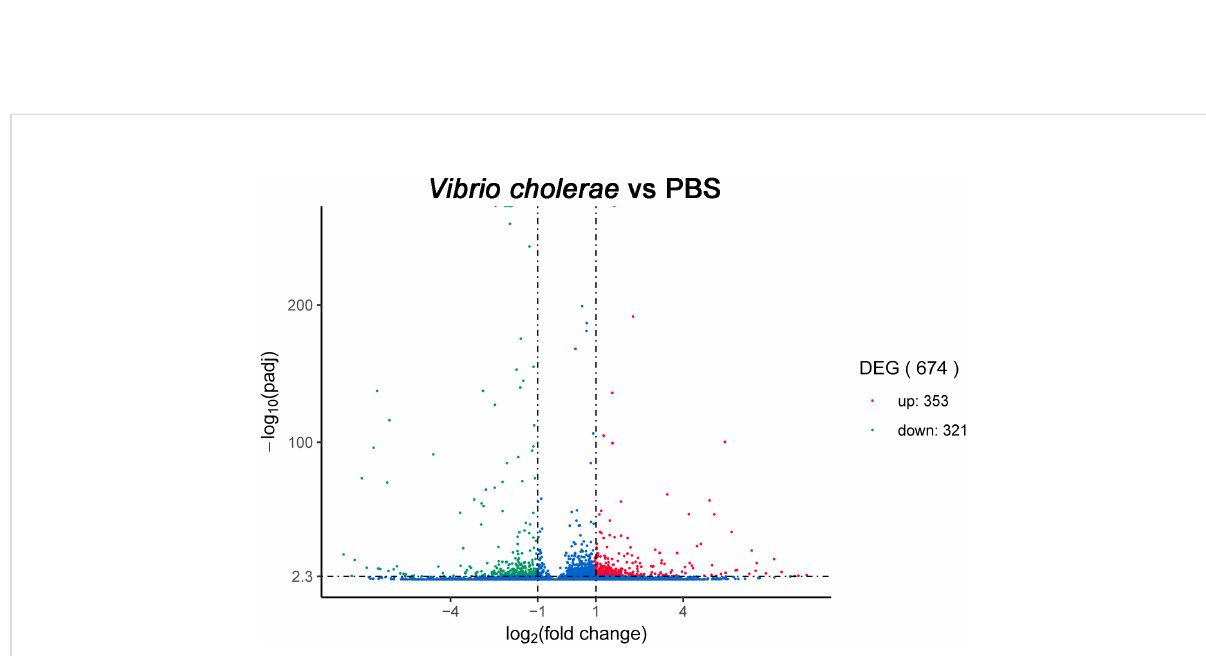
FIGURE 8 Volcano plot of the differentially expressed genes in head kidney of yellow cat fi